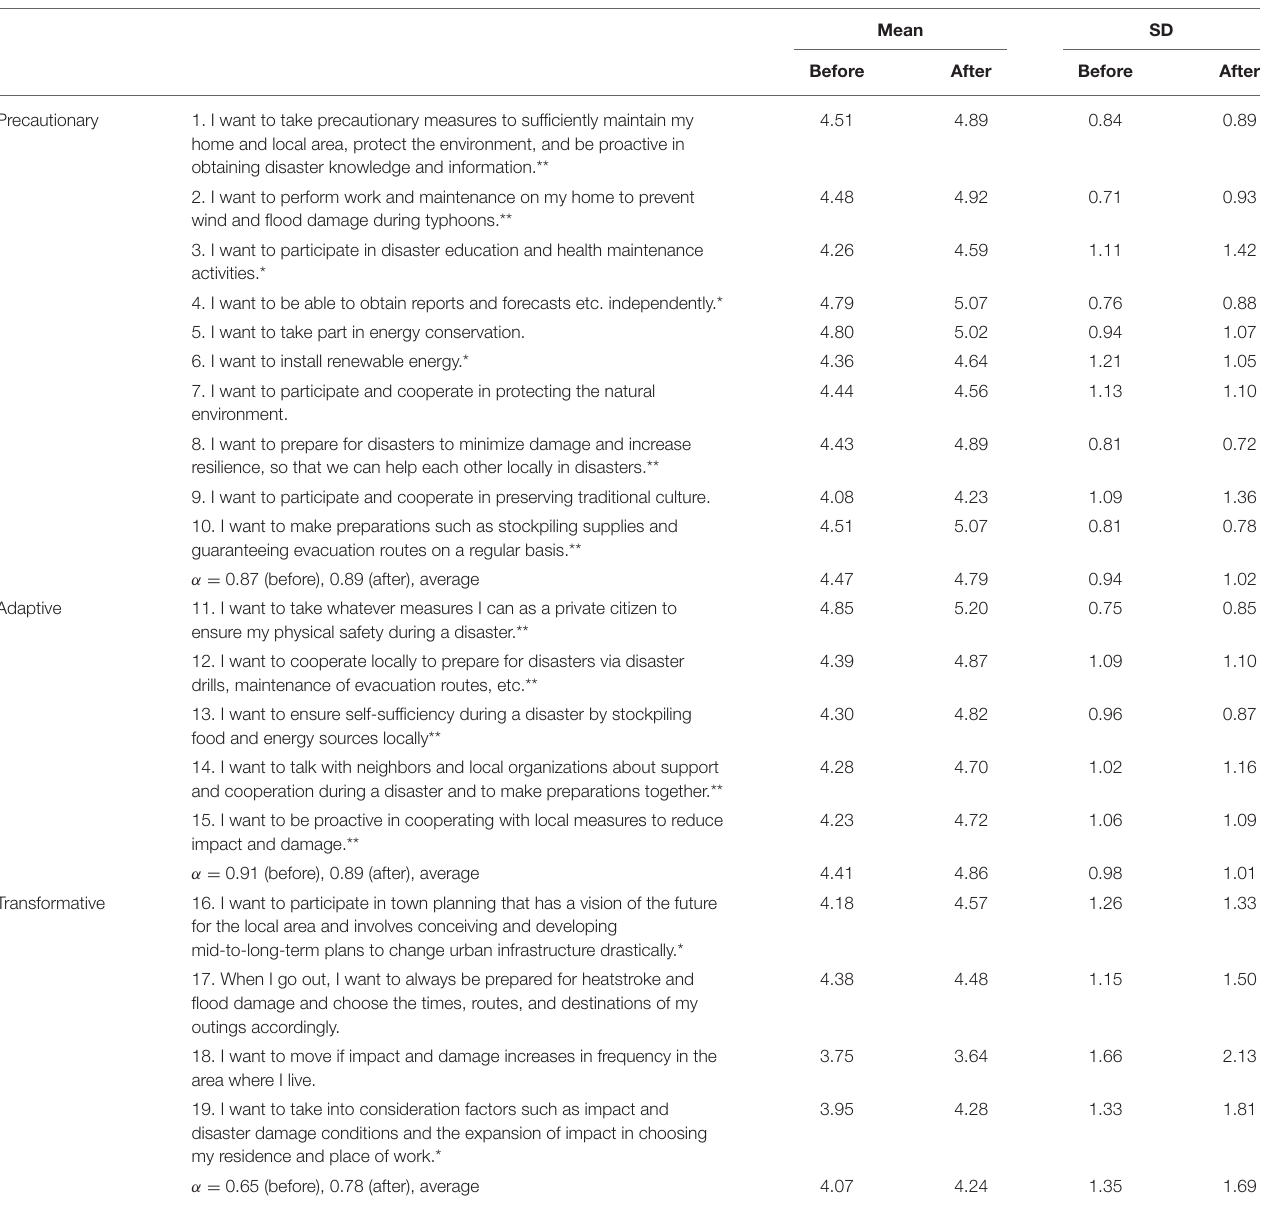
TABLE 5 | Pros and cons of climate change adaptation policies in disaster prevention (that individuals can take).